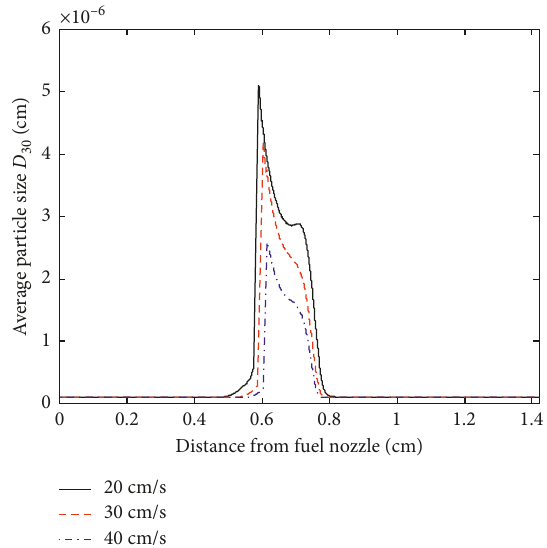
Figure 5: Profile of soot volume fraction. Circles are measurement data from [28].